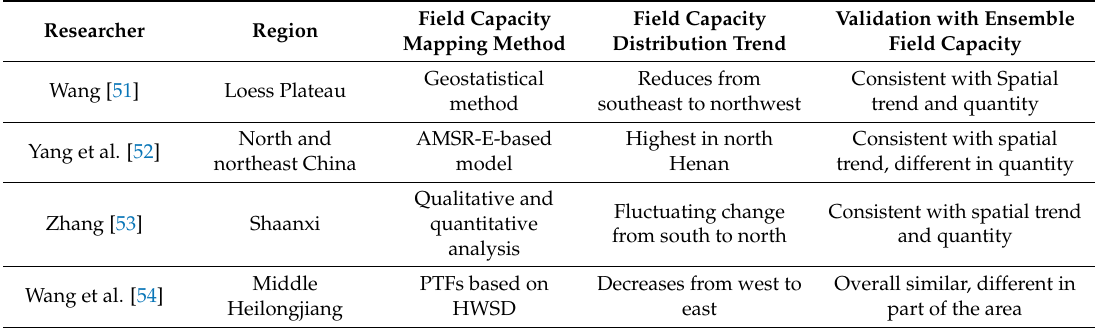
Table 3. Summary of regional validation. The specific location information of these four places can be found in Figure 1.